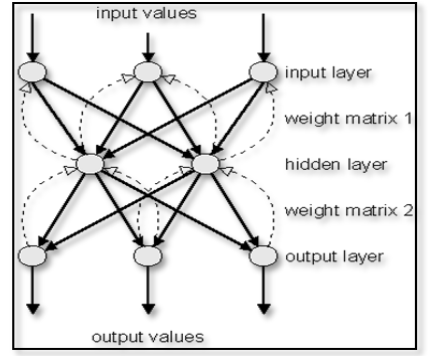
Figure 2. The structure of back propagation artificial neural